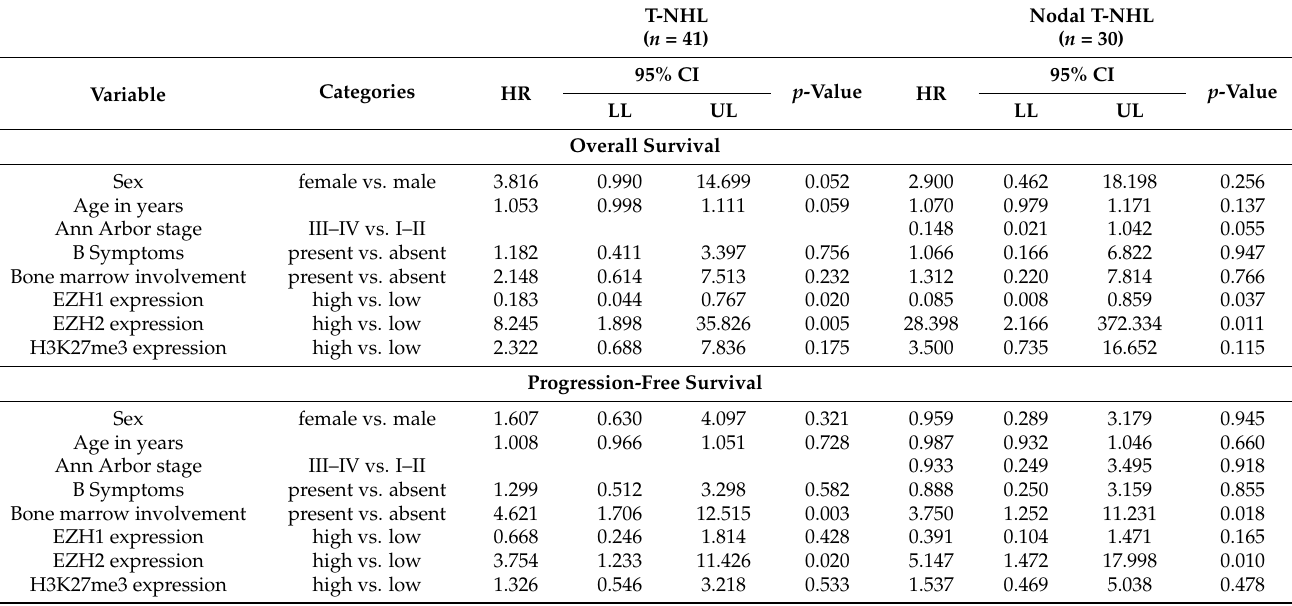
Table 3. Multivariable analysis of overall survival (OS) and progression-free survival